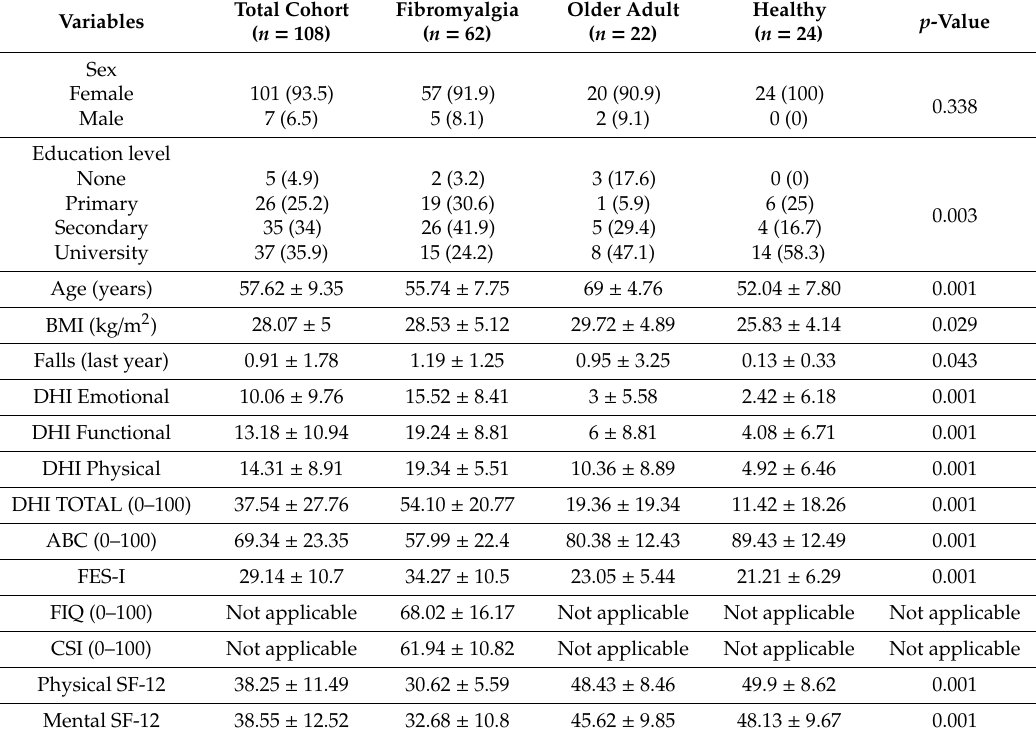
Table 1. Descriptive characteristics for the whole cohort and for the three populations separately.